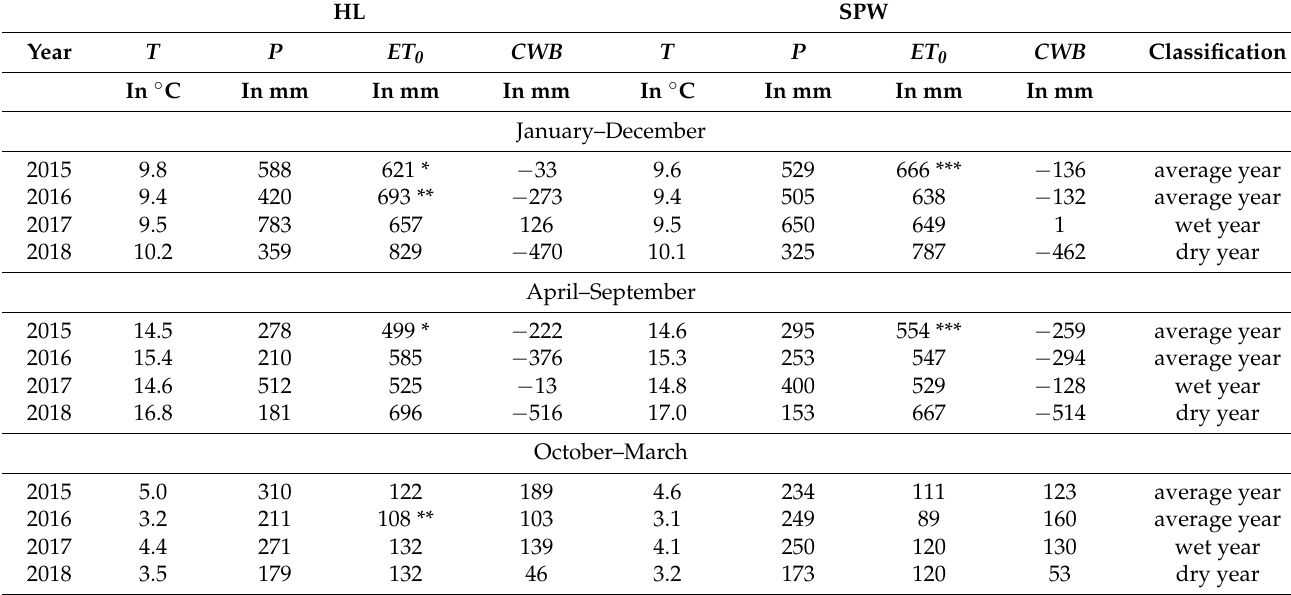
Table 2. Meteorological key numbers from 2015 to 2018 in Havelländisches Luch (HL) and Spreewald (SPW) (station failures in HL: * 15 days in May/June 2015, ** 9 days in October 2016, 2 days in December 2016, in SPW: *** 2 days in August 2015, T —average air temperature, P —sum of precipitation, ET 0 —sum of FAO grass reference evapotranspiration, CWB –sum of climatic water